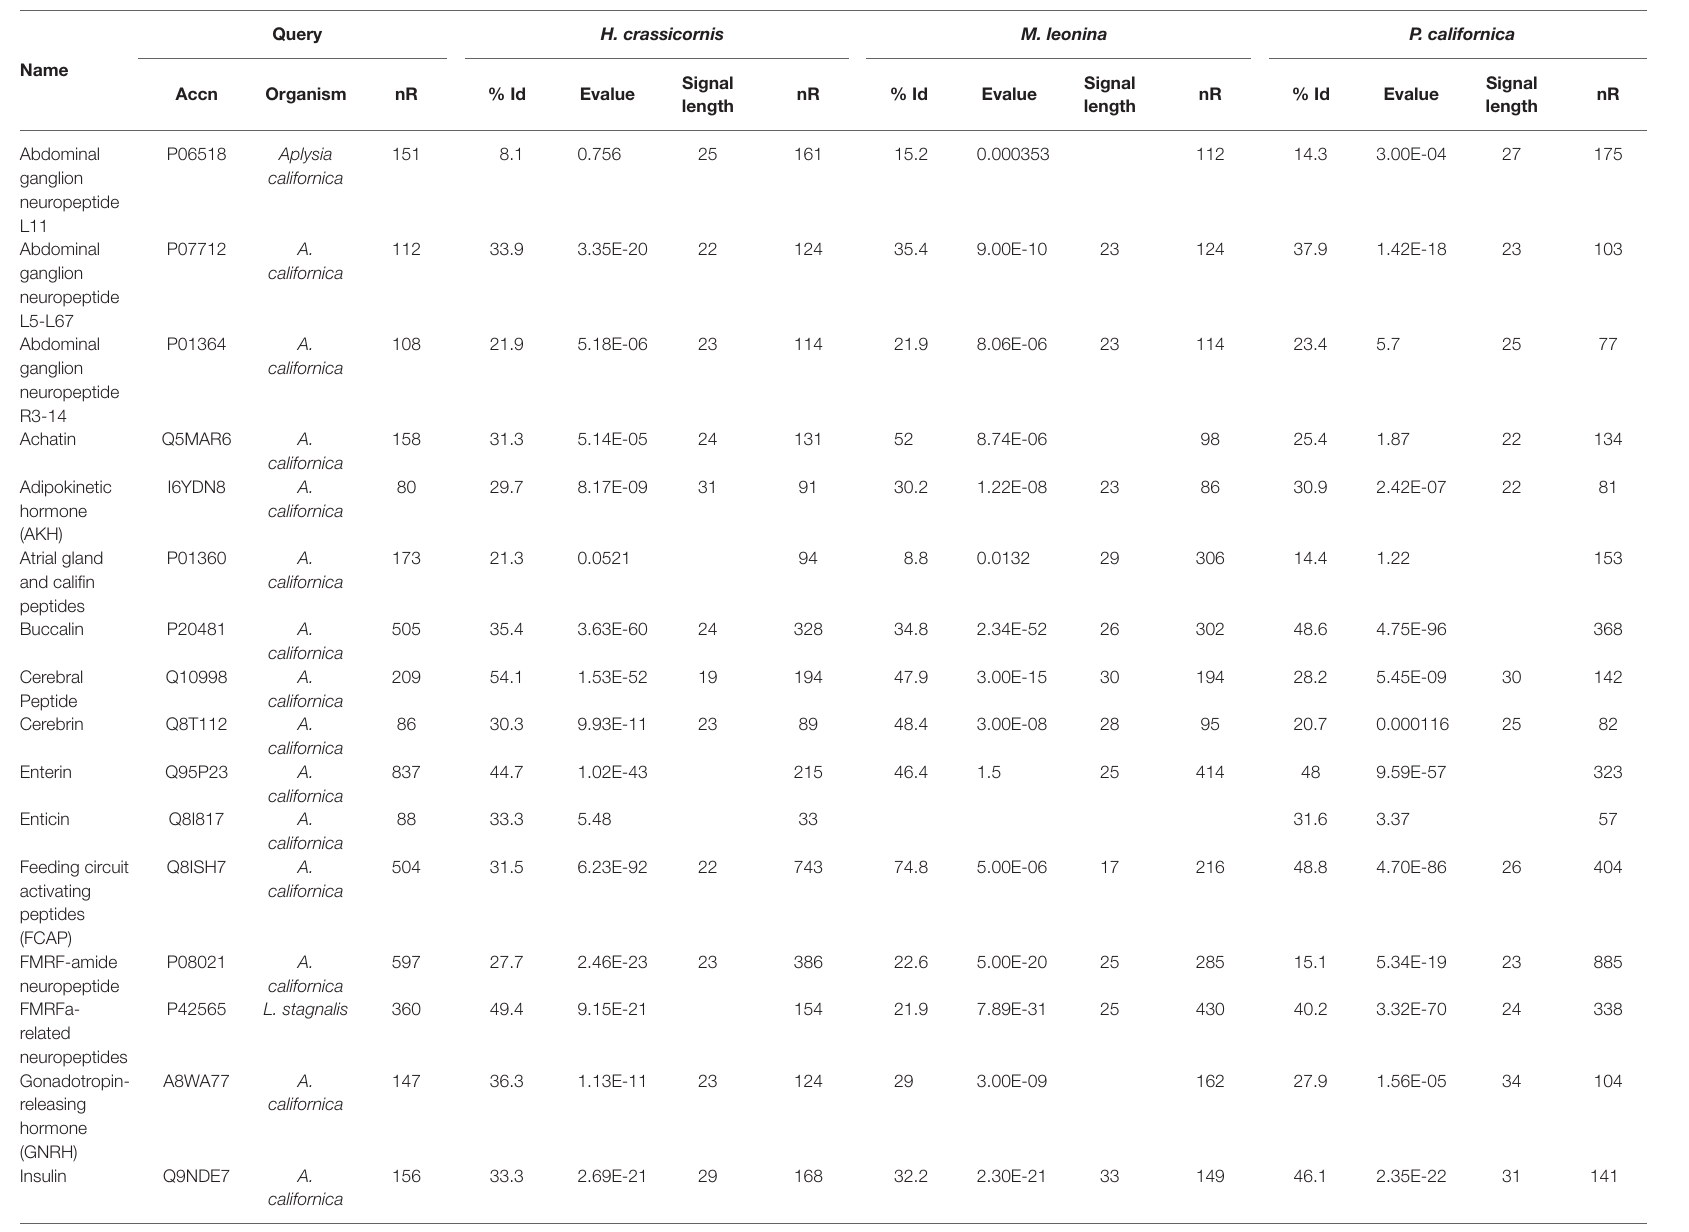
TABLE 1 | Prohormone annotations of each species’ CNS